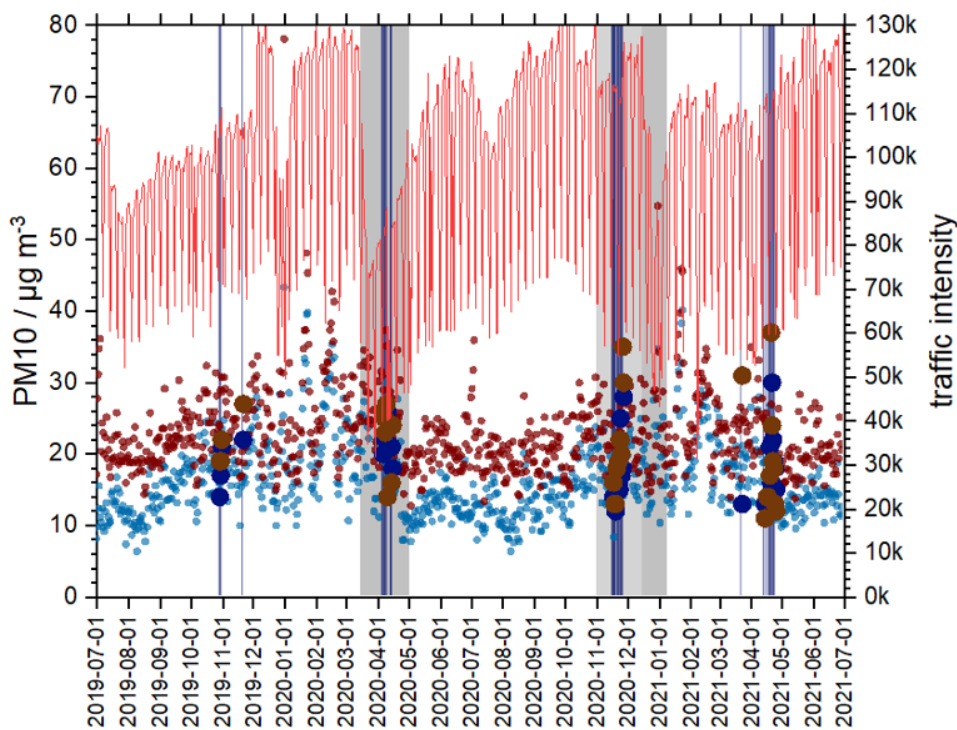
Figure 2. Two-year period from mid-2019 through mid-2021 showing daily data of averages of the PM10 concentration of the past five years (e.g., the left-most data points are averages of the 1 July data of the years 2014–2018) for the traffic station VMS2 (brown) and urban background station MSGE (blue); days of bicycle rides (vertical blue lines); daily PM10 averages of the city (total traffic counts per hour) during these days (large brown dots for VMS2; large blue dots for MSGE); gray-shaded vertical areas represent lockdown periods (dark gray shades for national lockdowns; one light gray shade for “lockdown light”); and daily data for traffic intensity (red).